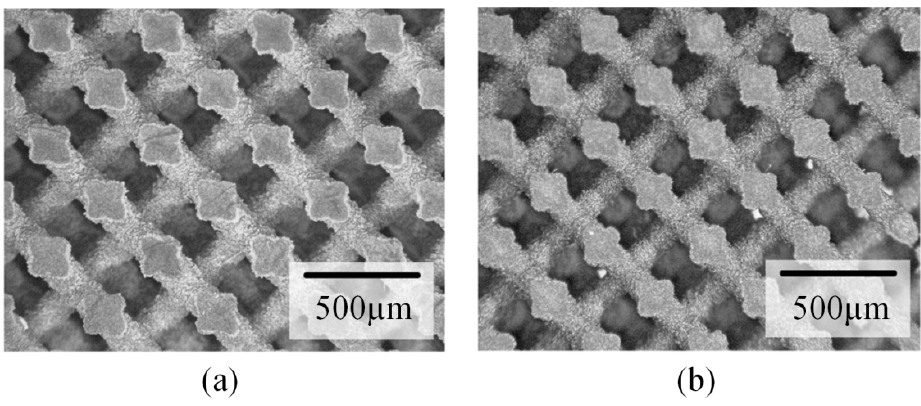
Figure 4. An acryl diamond lattice with metallic glass (Fe O ·Bi O (B 2 3 2 3